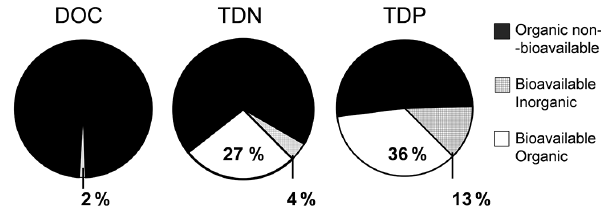
Figure 3. Proportion of organic non-bioavailable, organic bioavail- able and inorganic nutrient shares of dissolved organic carbon (DOC), total dissolved nitrogen (TDN) and total phosphorus (TP) for all lakes and all sampling occasions ( n = 26).